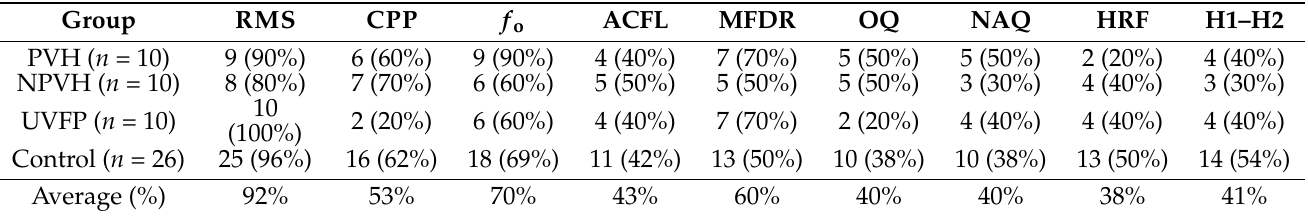
Table 6. For each participant group, the average inclusion frequency (count and percentage) is reported for each vocal function measure that was input into Ps Estimation Method 3 (multiple regression model).